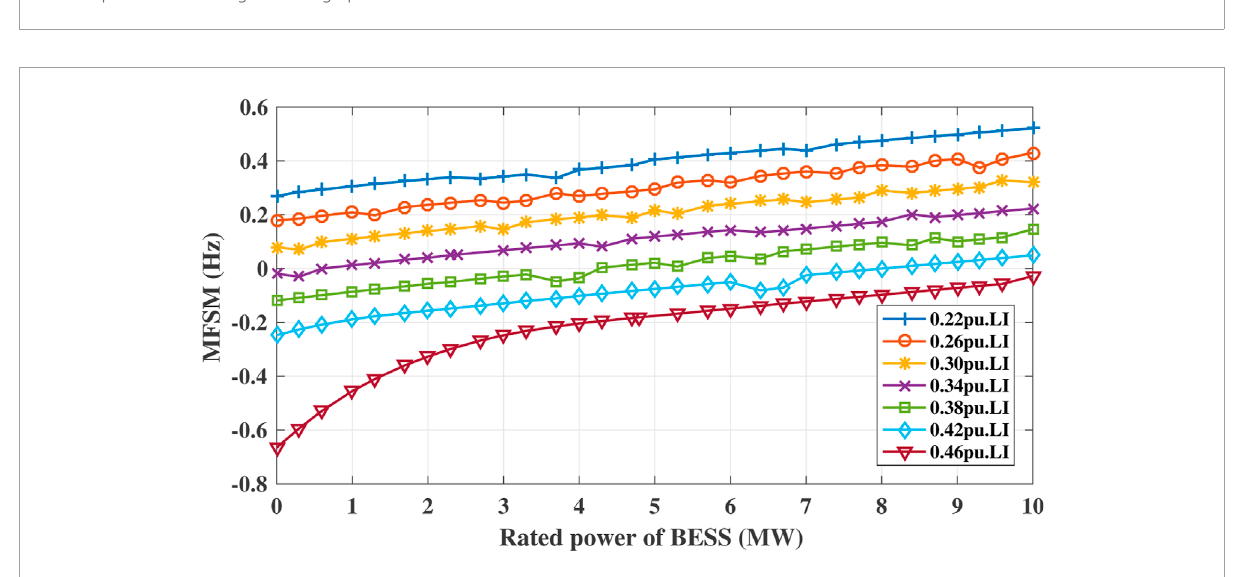
FIGURE 6 The variation of MFSM with the rated power of BESS following different load increase